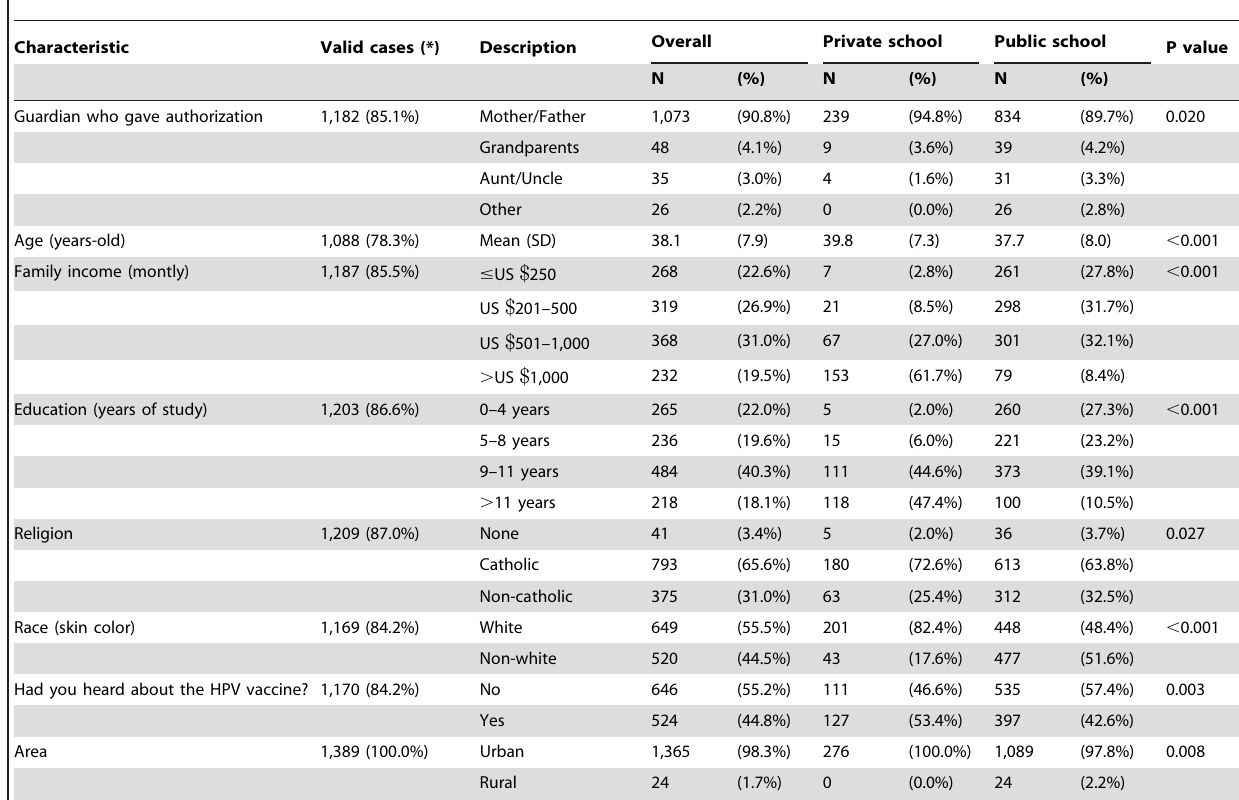
Table 1. Characteristics of the parents and guardians of the girls who agreed to participate in the vaccination program according to school type (n=1,389).